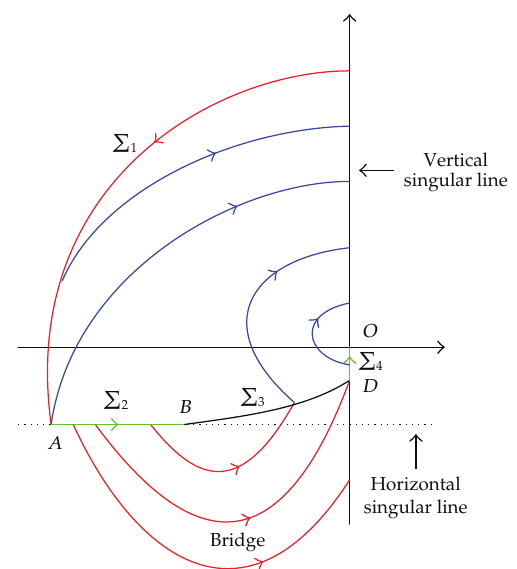
Figure 1: Global synthesis from the north pole. The switching locus Σ is formed by the union of the surfaces Σ i . Due to the symmetry of revolution, the cut locus corresponds to the z